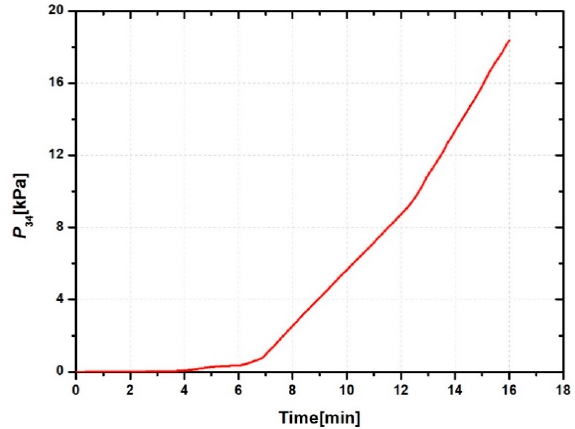
Figure 11. Integrating result of the high-pressure turbine discharge pressure.